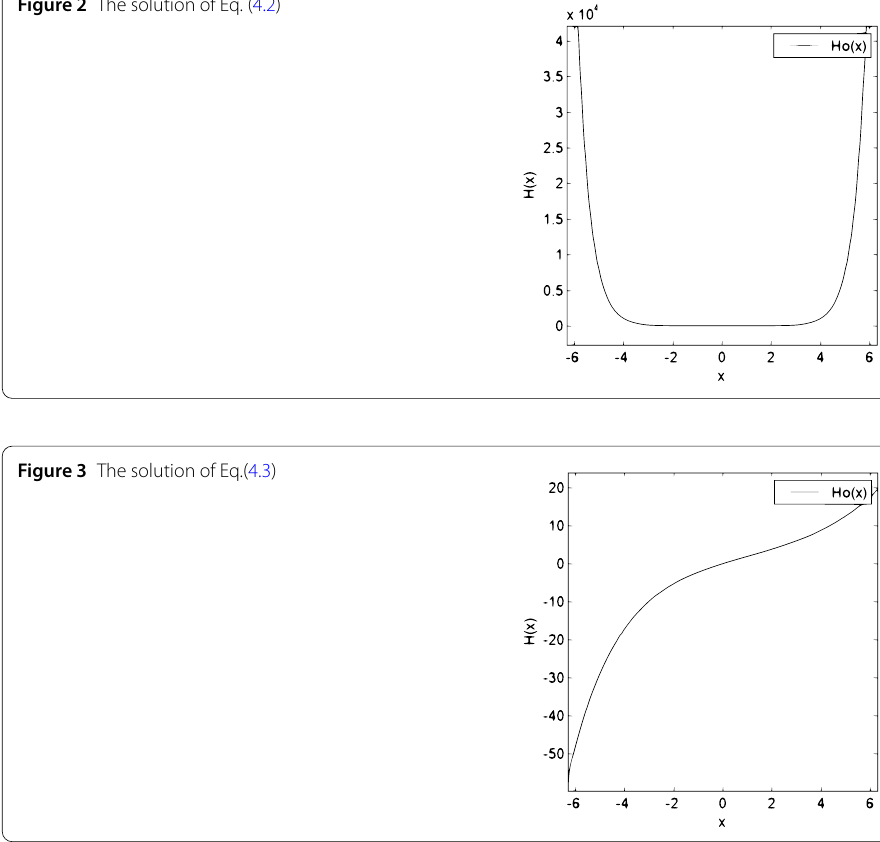
Figure 2 The solution of Eq. (4.2)